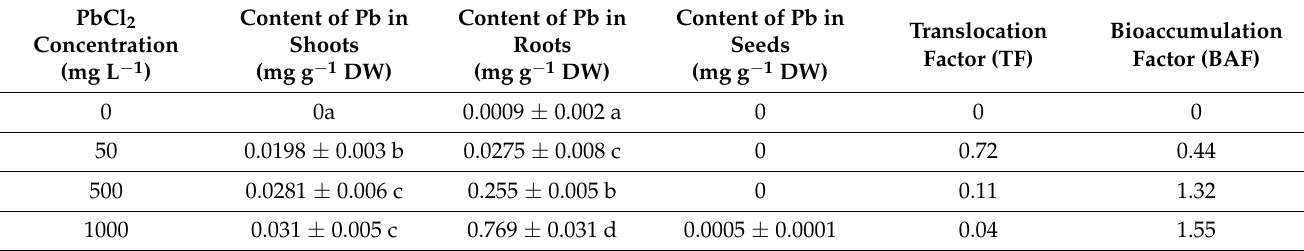
Table 1. Pb content in harvested roots, shoots and seeds of stressed fenugreek seedlings under PbCl 2 treatment (0, 50, 500 and 1000 mg L − 1 ) and evaluation of TF and BAF. All the values are means of triplicates ± SD. ANOVA is significant at p < 0.05. Different letters indicate significantly different values at particular lead concentrations (DMRT, p <